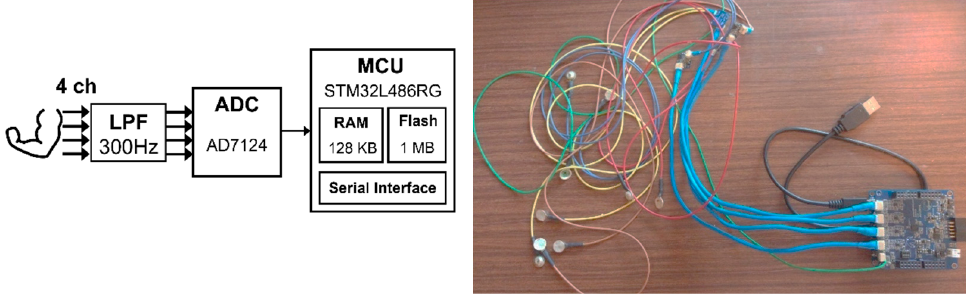
Figure 2. Hardware acquisition system, left block design, and right picture of the system.